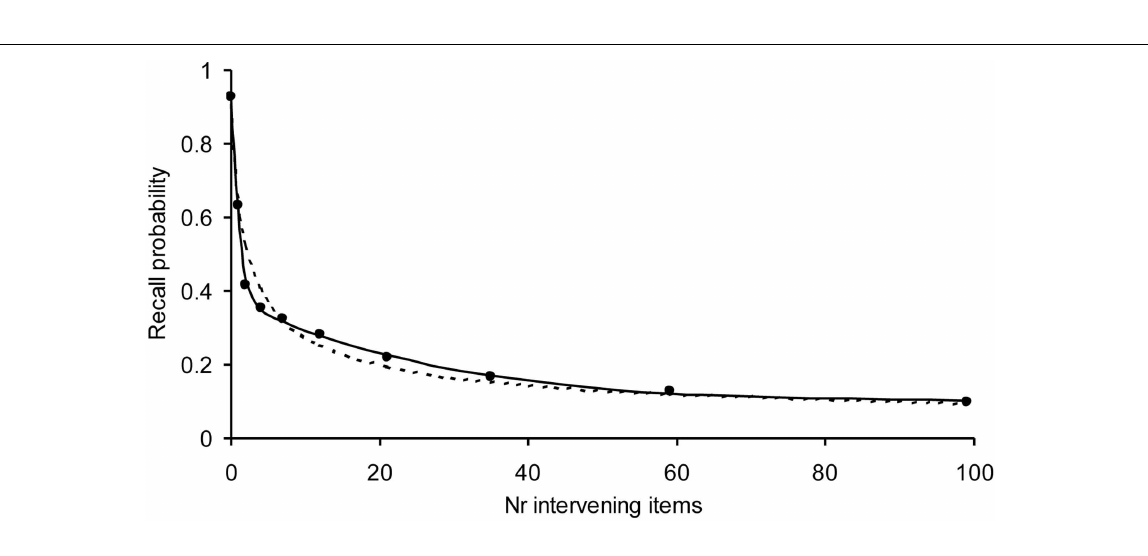
FIGURE 3 | Example application of the Memory Chain Model to a forgetting curve, with a high number of observations per data point using a three-process recall probability function (solid curve) and the power-law (dotted curve). The recall data are word pairs from Rubin et al.